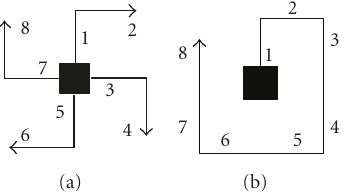
Figure 13: (a) Semiparallel and (b) serial switched broadcasting.